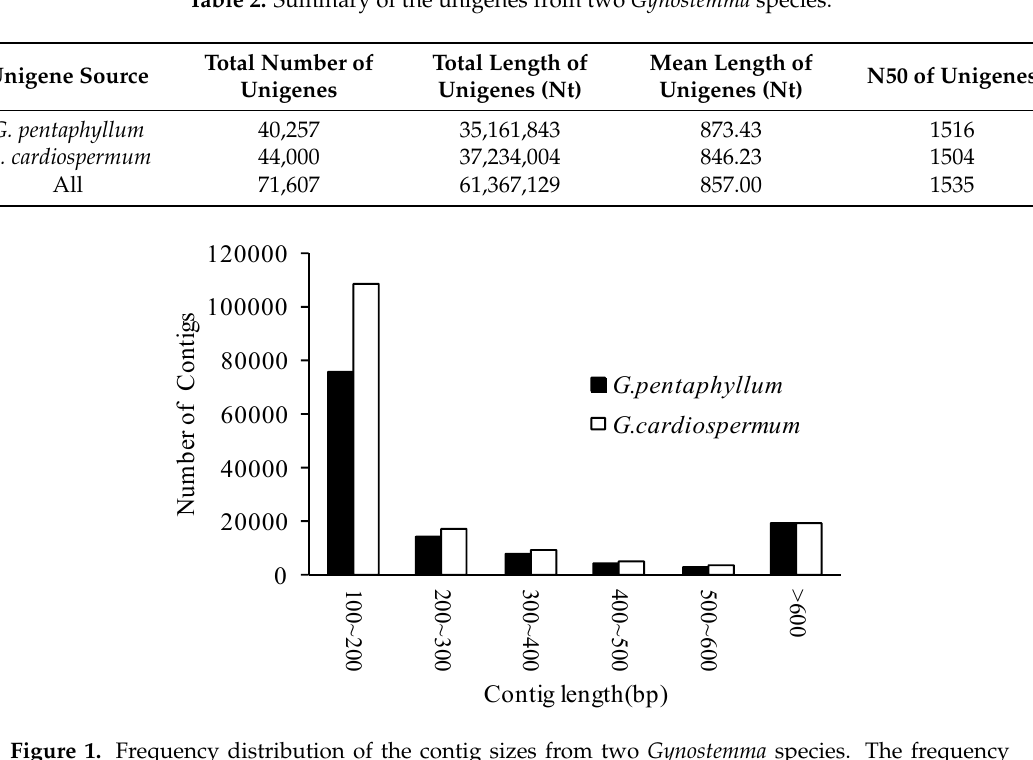
Table 1. Transcriptome reads and assembled contigs information for two Gynostemma species.